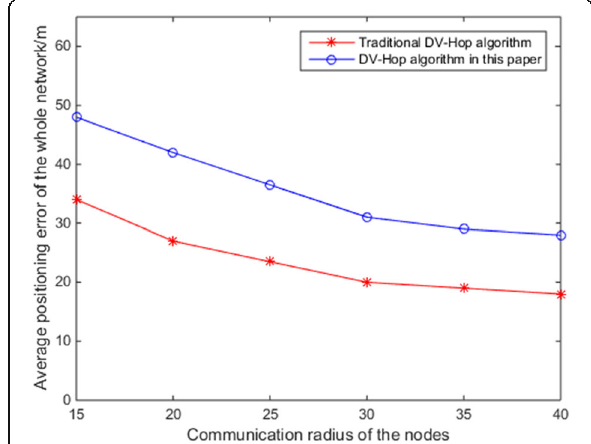
Fig. 6 The relationship between the average positioning error and the communication radius of the